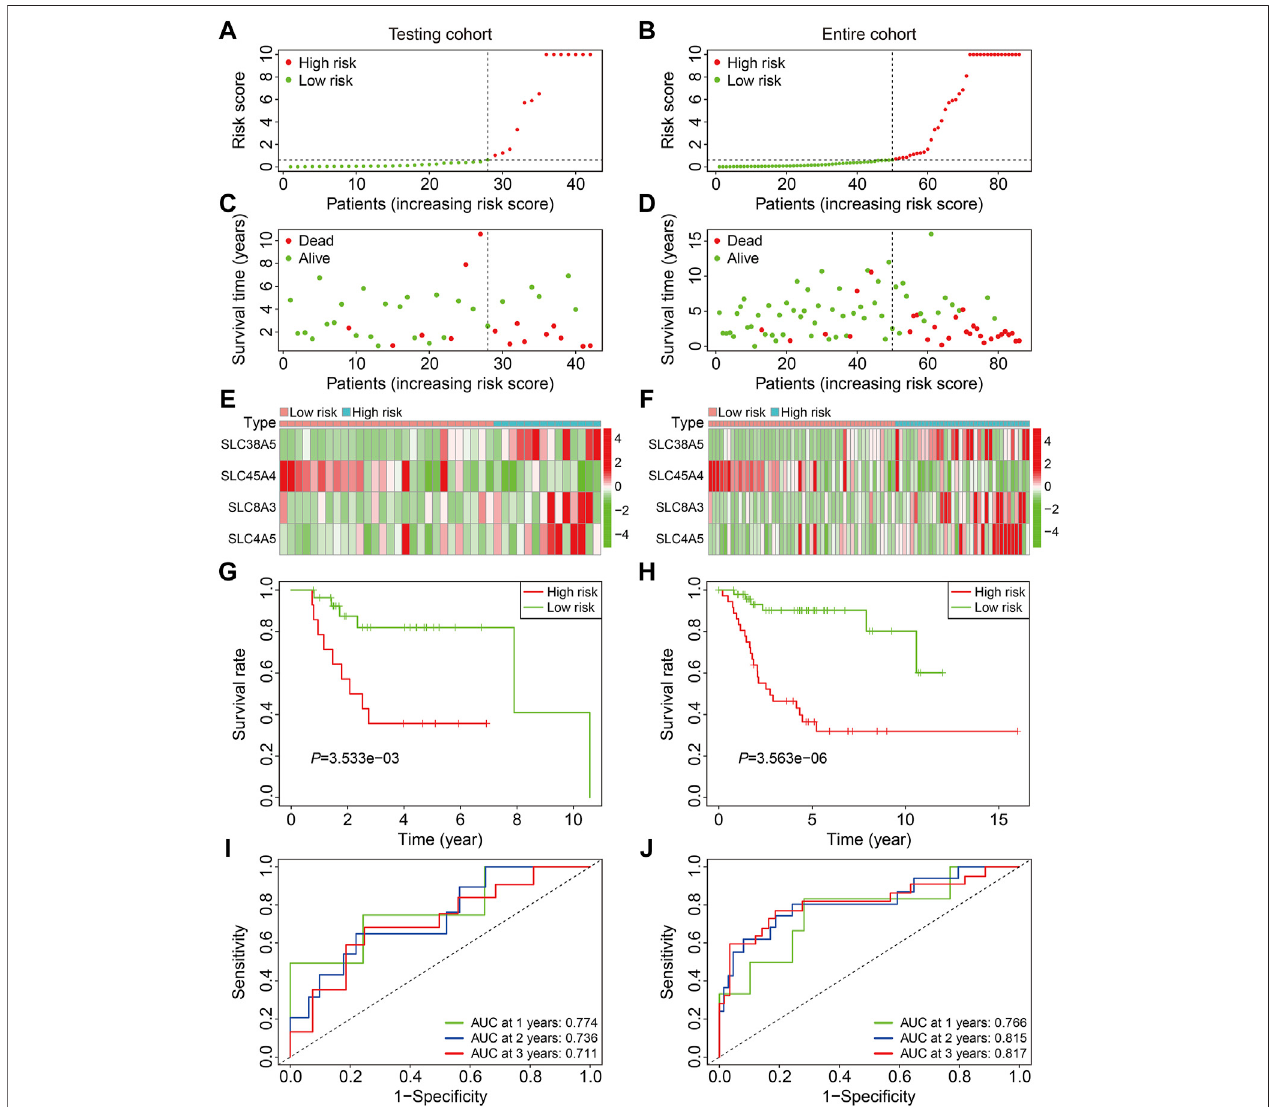
FIGURE3| ValidationoftheSLCgenesignatureininternalcohorts. (A,B) Distributionofpatients ’ riskscoreintestingandentirecohorts.Thehorizontaldashedline representsthemedian riskscoreintrainingcohort. Theverticaldashed lineisthedividinglinethatseparatespatientsintohigh-and low-riskgroups. (C,D) Distributionof survival status and survival time of patients in testing and entire cohorts. (E,F) The expression pro fi le of the four SLC genes in testing and entire cohorts. (G,H) Kaplan- Meier survival curves in testing and entire cohorts. (I,J) Time-dependent receiver operating characteristic curve analysis for the signature in testing and entire